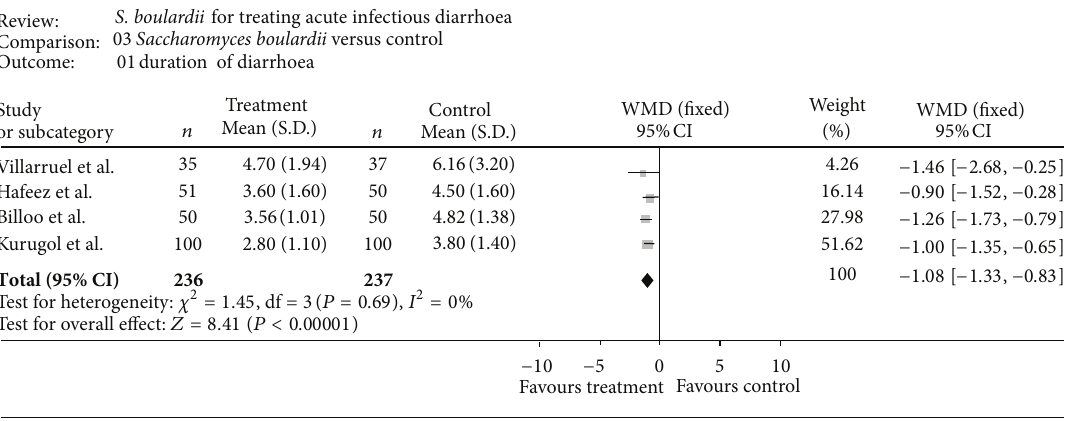
Figure 7: Efficacy of probiotics: mean duration of diarrhoea (hours) with Saccharomyces boulardii versus control [69].